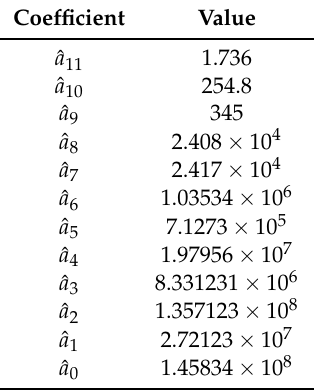
Table 2. Estimated coefficients of the characteristic